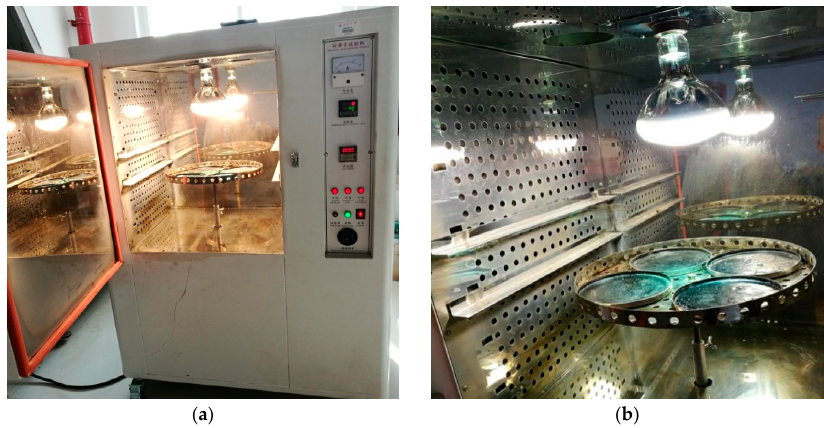
Figure 6. Yellowing-resistant aging box: ( a ) overall diagram; ( b ) detail.